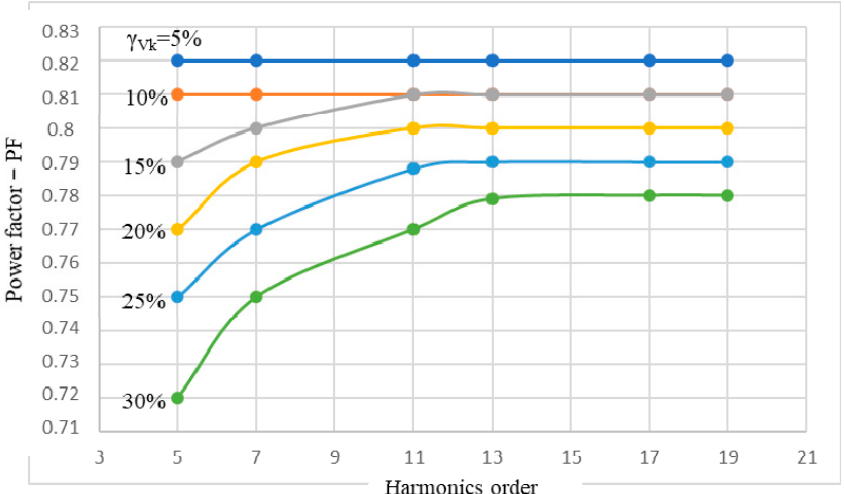
Figure 7. Power factor (PF) variations of the IM in the harmonics, related to the k-order of the voltage harmonics and their level γ Vk .